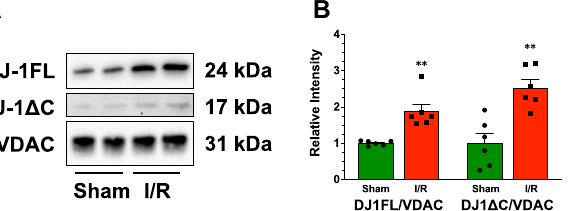
Figure 2. Ischemia–reperfusion injury enhances the localization of DJ-1 to the mitochondria. ( A ) Immunoblots and ( B ) analysis of the full-length (DJ-1FL) and cleaved (DJ-1ΔC) forms of DJ-1 in mitochondrial fractions. All measurements were performed in samples collected at 3 days of reperfusion from Wild-Type mice. Values are means ± SEM. 6 samples per group. Student’s T-test. ** p < 0.01 vs. Sham.